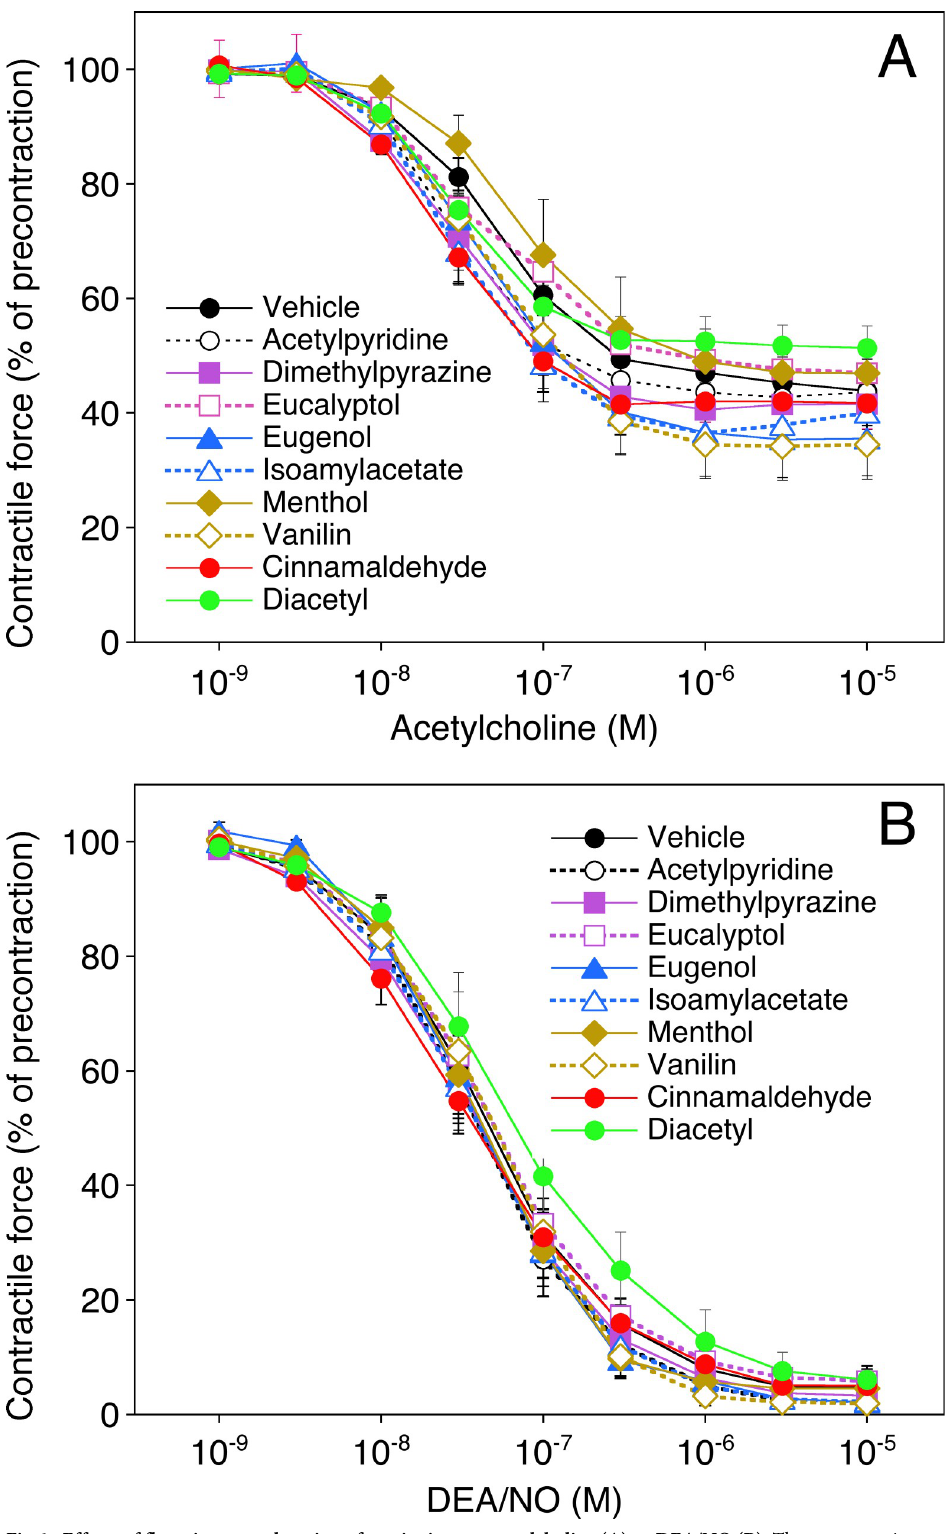
Fig 6. Effects of flavorings on relaxation of aortic rings to acetylcholine (A) or DEA/NO (B). The concentration- response to acetylcholine (1 nM—10 μ M) or DEA/NO (1 nM—10 μ M) was measured with U-46619